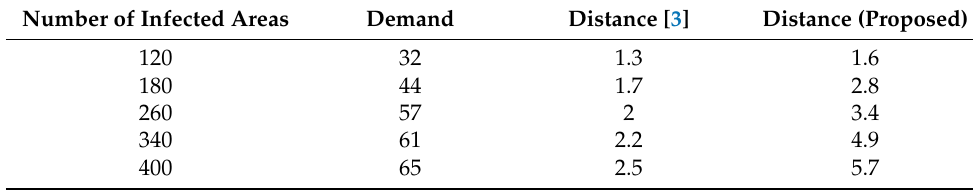
Table 4. Raised demand and distance.